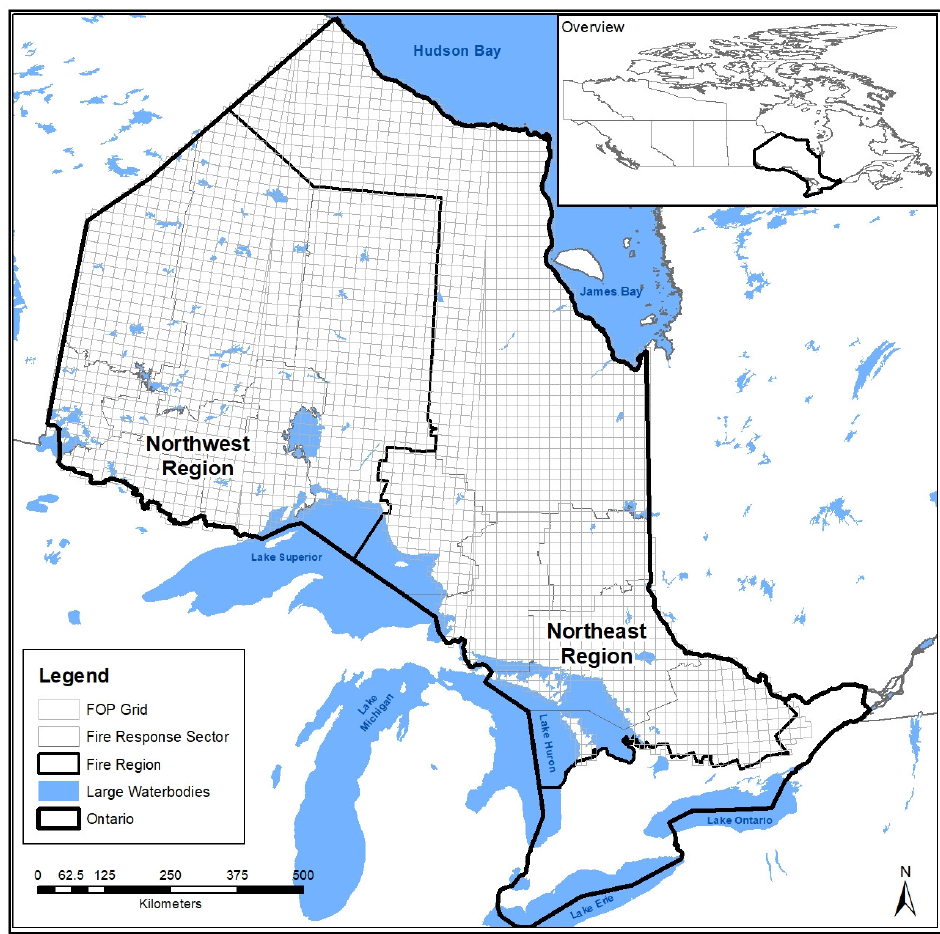
Figure 3. The approximately 91.9 million ha extent of Ontario’s fire management area and the 20 km × 20 km resolution of the fire occurrence prediction (FOP) grid for Ontario. 20 km × 20 km resolution of the fire occurrence prediction (FOP) grid for